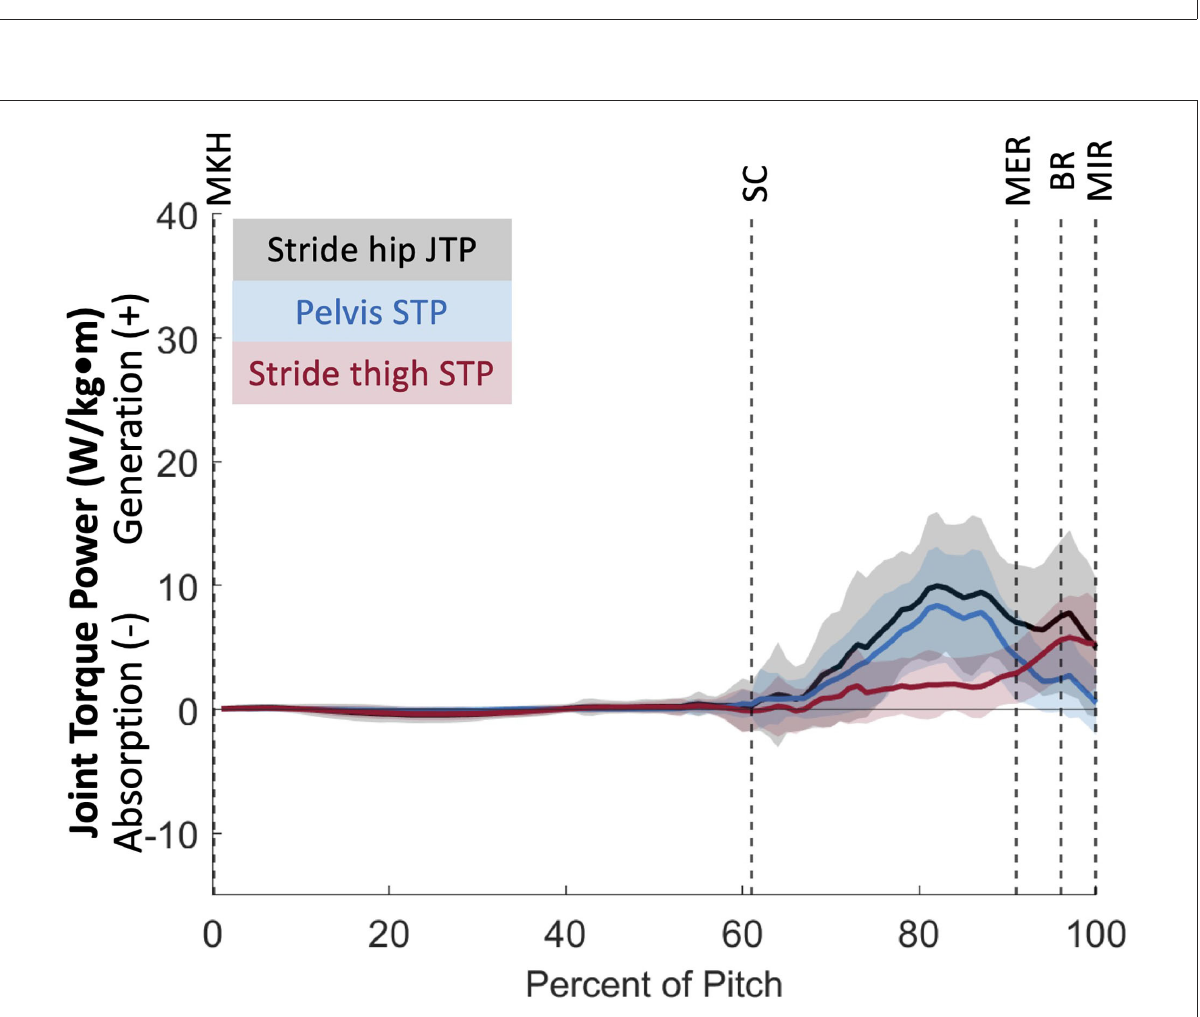
FIGURE14 Mean ± SD joint torque power for the stride hip (black) and its components of pelvis segment torque power (blue) and stride thigh segment torque power (red) for the duration of the pitch from maximum knee height (MKH) to maximum internal rotation